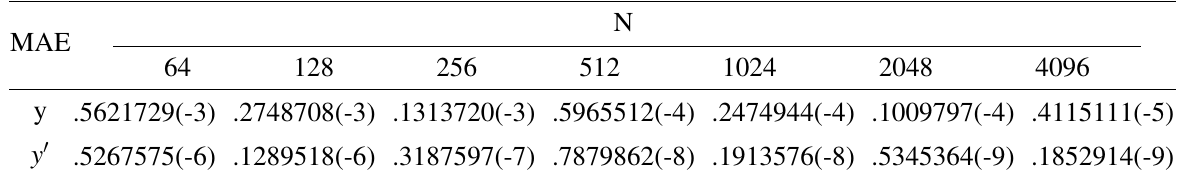
− 20 ) and y (cid:48) ( x ) for Example 5.1 . x